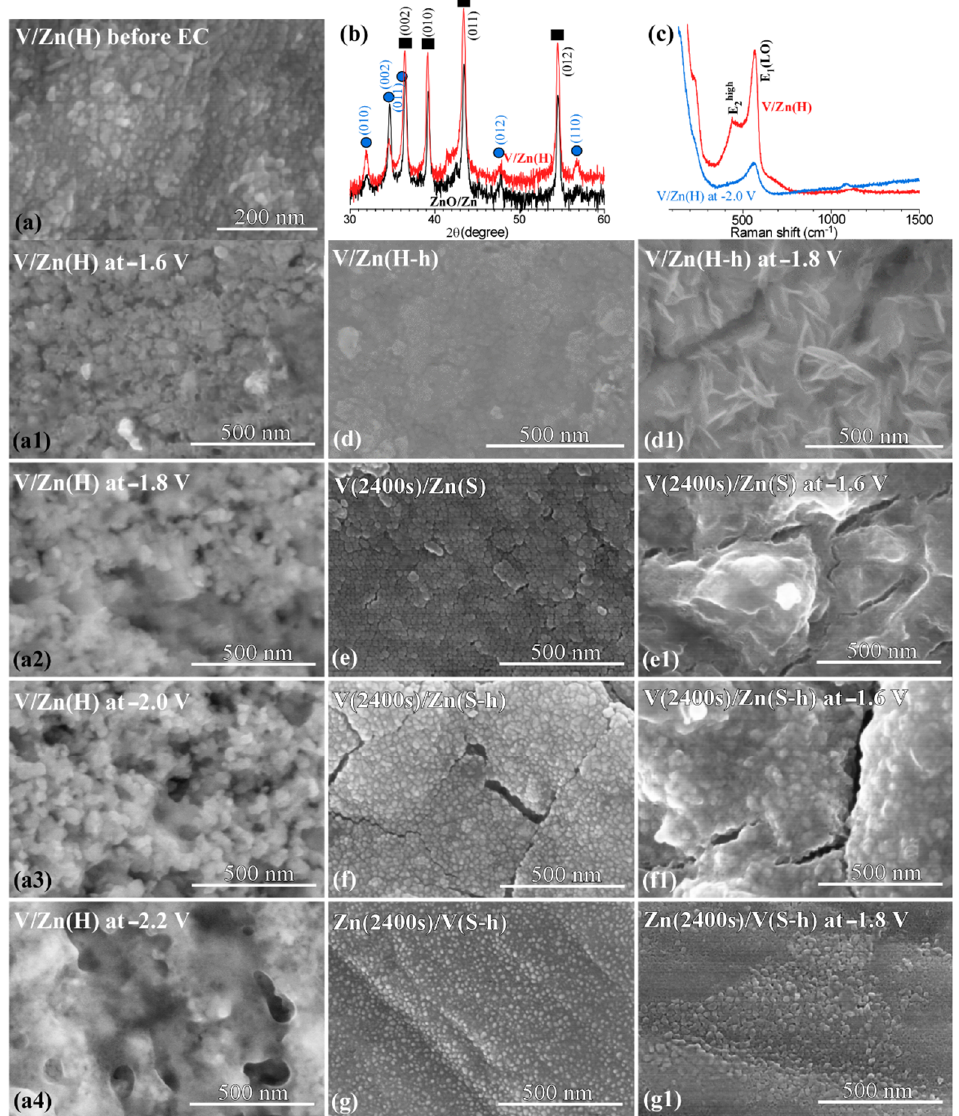
Figure 6. SEM images of V/Zn(H) electrode before ( a ) and after EC at various applied potentials ( a1 – a4 ). XRD profiles ( b ) of V/Zn(H) and ZnO/Zn (reference). Raman spectra of V/Zn(H) electrode before and after EC at − 2.0 V ( c ). V/Zn(H-h) ( d , d1 ), V(2400 s)/Zn(S) ( e , e1 ), V(2400 s)/Zn(S-h) ( f , f1 ), and Zn(2400 s)/V(S-h) ( g , g1 ) electrodes before and after EC.